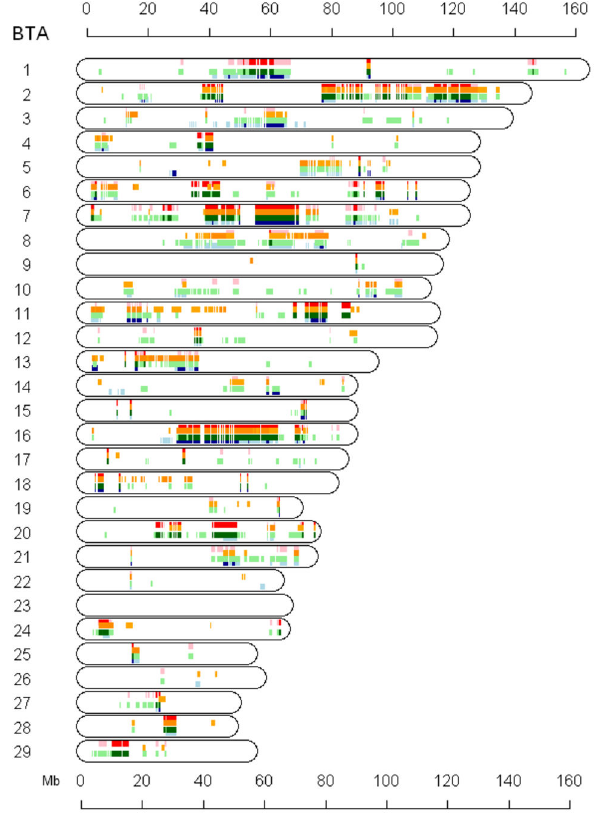
Figure 4. Associations between the most frequent haplotype and birth year and milk yield traits. Associations are plotted against chromosomal regions. Red, blue, orange, and green bars denote an association between Group II-A haplotypes and birth year, milk yield, fat, and protein, respectively (light color = suggestive at p<0.05, dark color = significant at p<0.01). doi: